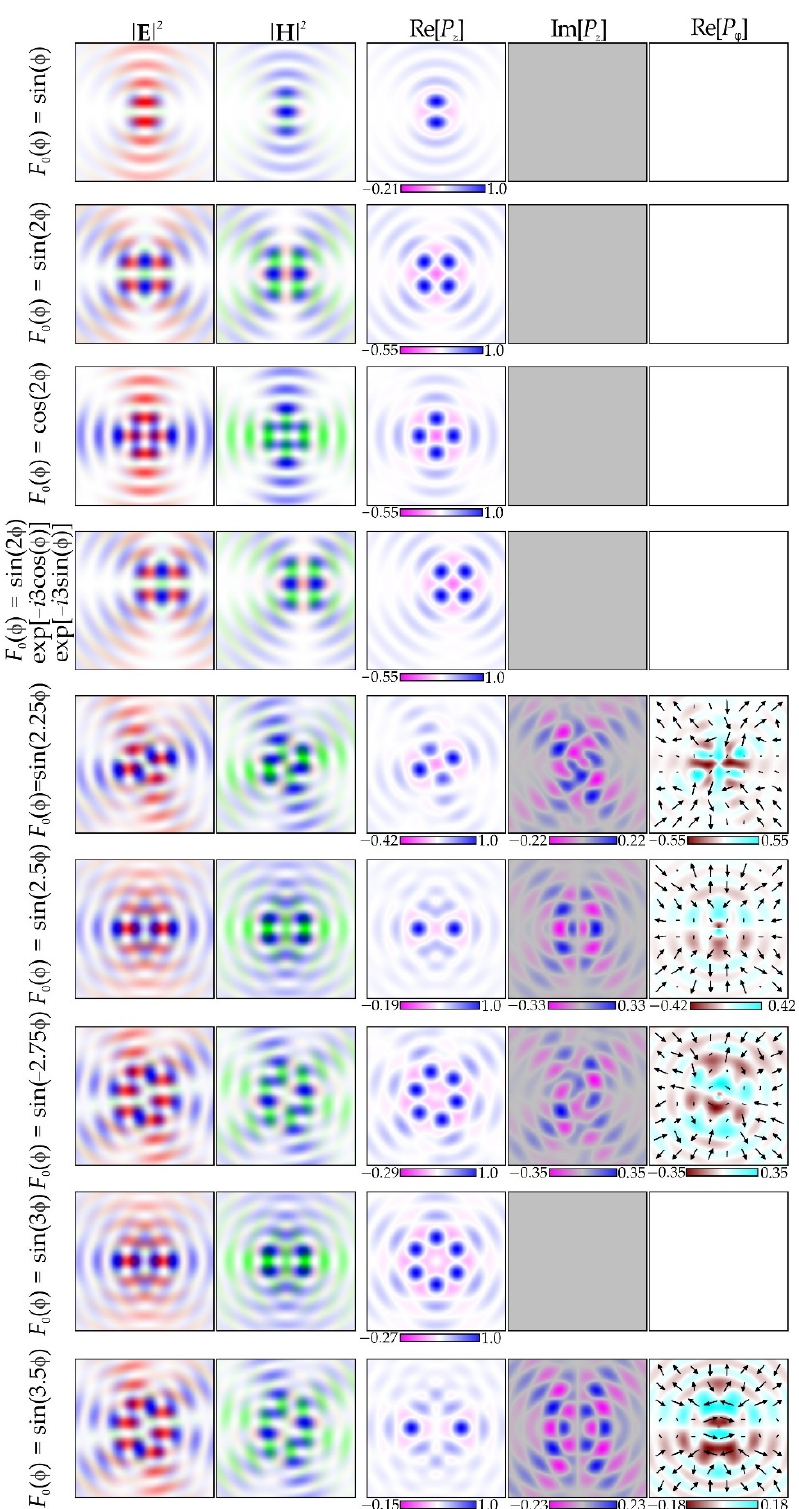
Figure 3. Simulation results for amplitude spiral plates (red color—for x -components, green color— for y -components, and blue color—for z -components). The distributions in the focal plane with a size of 4 λ × 4 λ are shown.